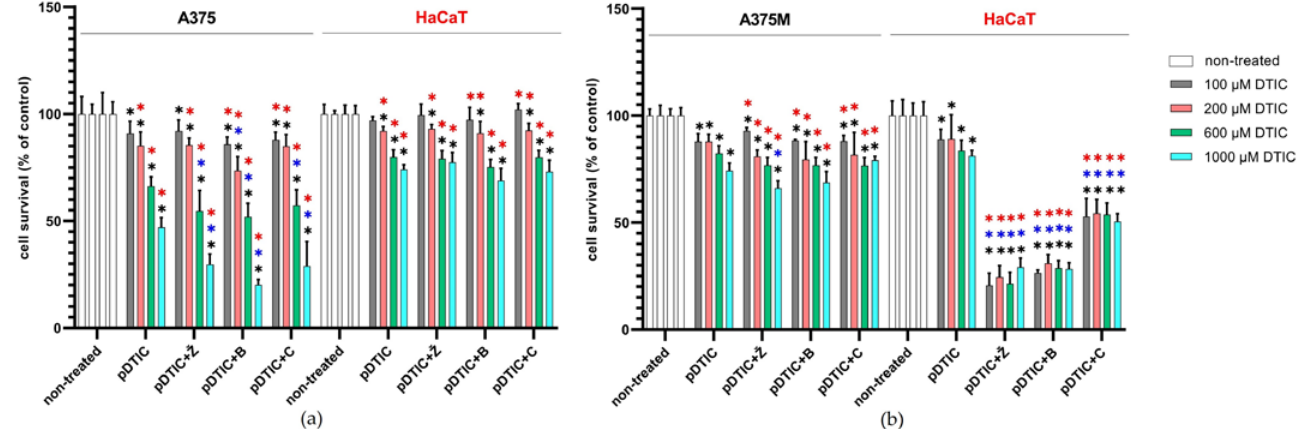
Figure 4. Effect of EVOO-PEs derived from three different cultivars (Žižolera, Bjelica, and Crnica) on cellular metabolic activity after pre-treatment with DTIC. Cells were pre-treated with various concentrations of DTIC (100, 200, 600, or 1000 µM) for 6 h and afterwards exposed for 24 h to EVOO-PEs in concentrations corresponding to the IC 60 values for ( a ) the A375 melanoma cell line and ( b ) the A375M metastatic melanoma cell line. In both cases, comparative non-cancerous HaCaT cells were exposed to the same concentrations of EVOO-PEs as applied to A375 and A375M cells. Metabolic activity was measured using an MTS assay. The results of the six experiments are expressed as mean percentage of cell viability compared to non-treated cells ± SD. Statistically significant differences ( p ˂ 0.05) are marked as follows: black asterisk—compared to the non-treated cells; blue asterisk—compared to the cells pre-treated with DTIC; red asterisk—difference between melanoma and HaCaT cells. Legends: pDTIC—pre-treatment with DTIC; pDTIC + Ž, pDTIC + B, pDTIC + C—pre-treatment with DTIC followed by exposure to EVOO-PEs derived from three different cultivars, Žižolera , Bjelica, and Crnica, respectively.